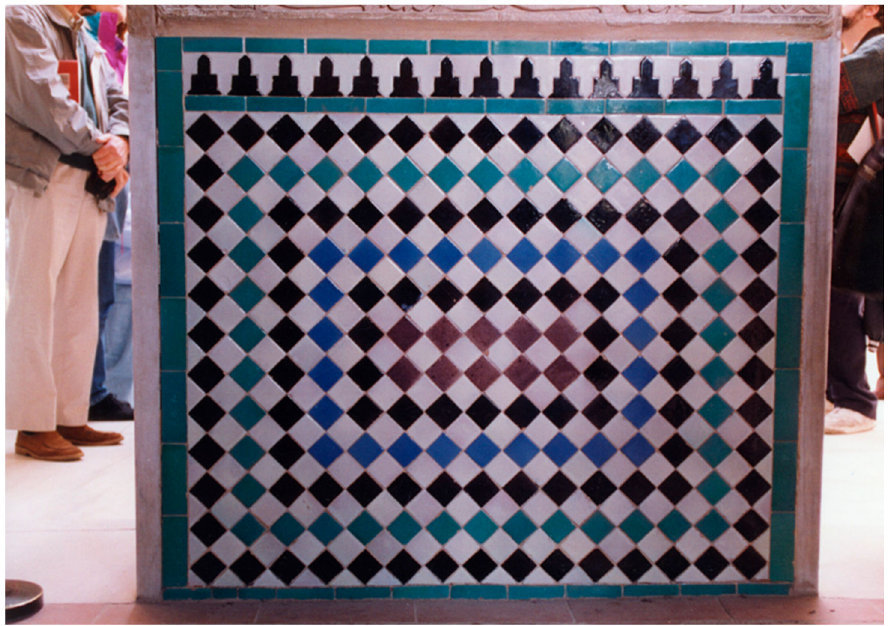
Figure 27. Refurbished ceramic dado of the south wall of the Cuarto Dorado in 1994. © Archivo del Patronato de la Alhambra y Generalife, Photograph Collection,